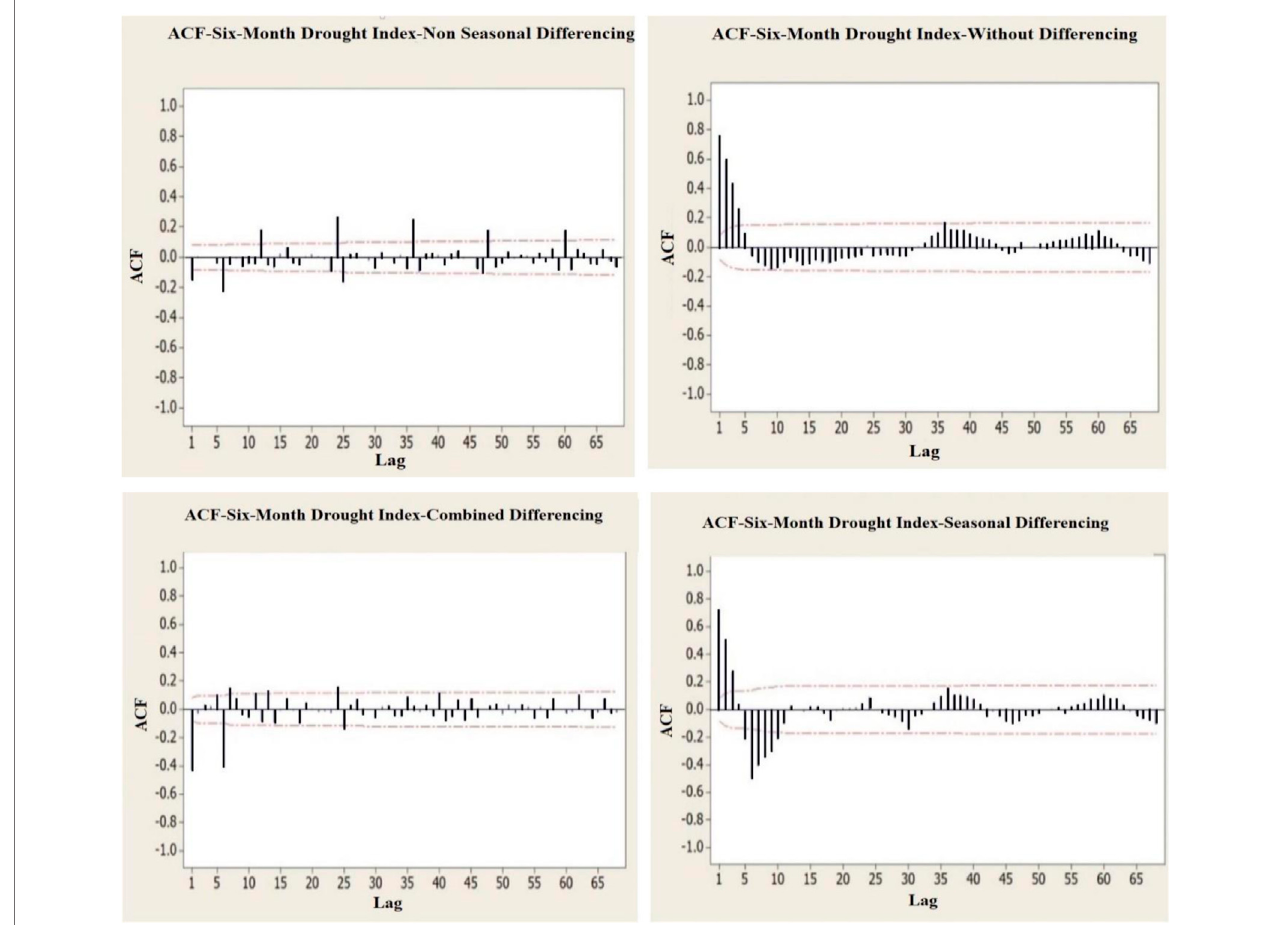
FIGURE 6 | Autocorrelation diagrams of different states of six-month drought index time series.